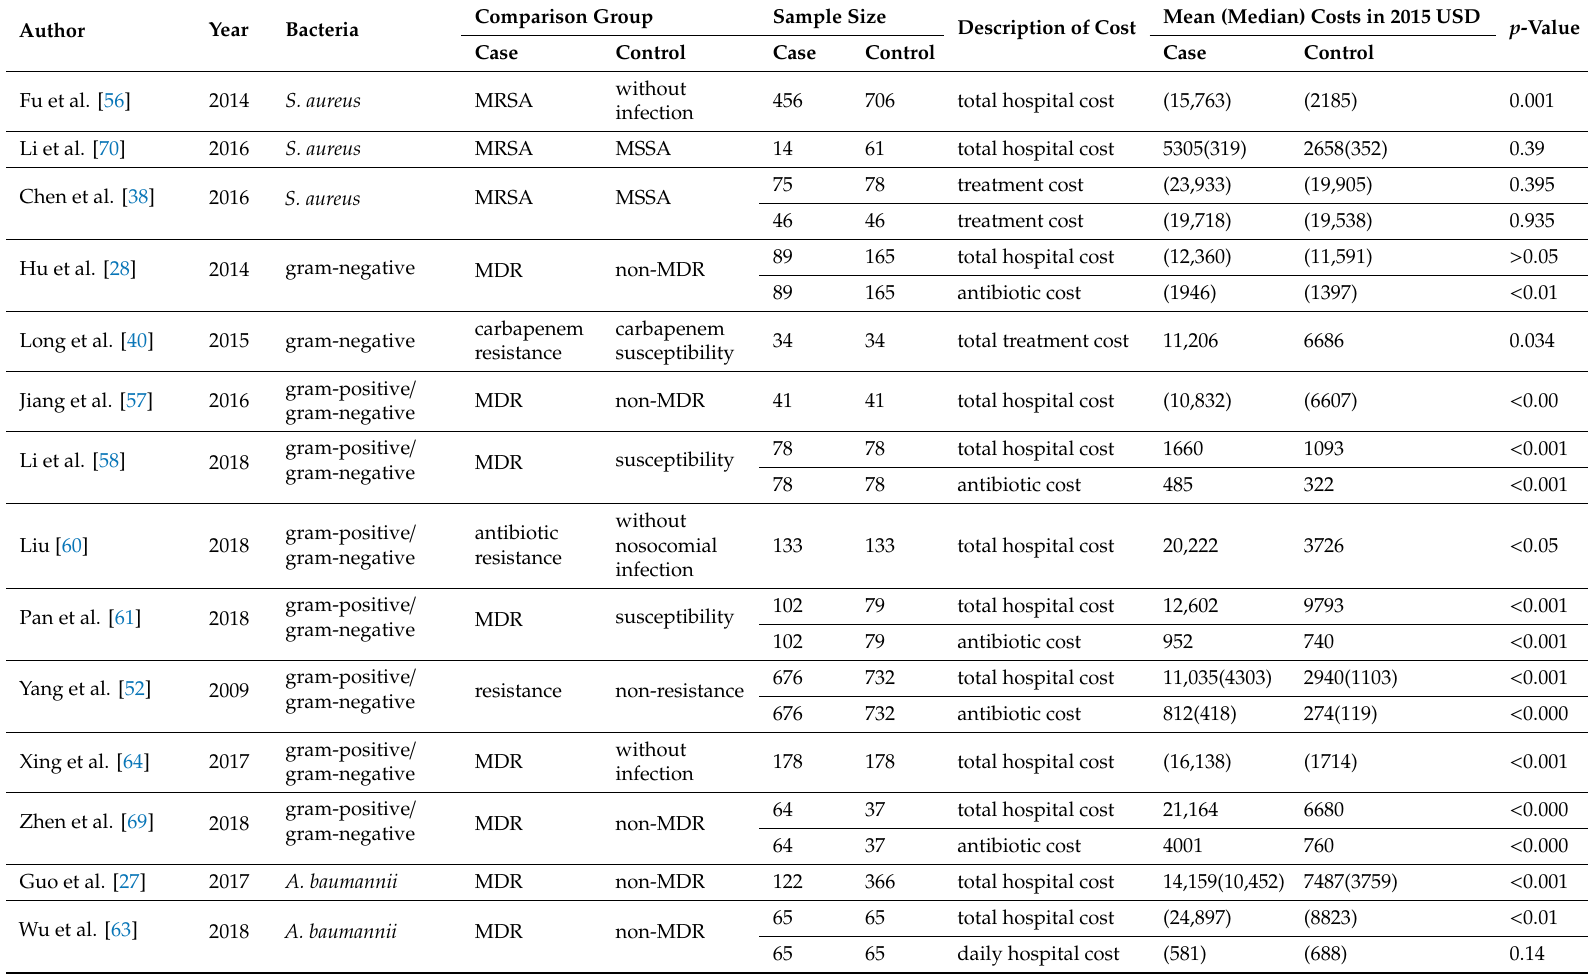
Table 3. Studies describing hospital costs among patients with antibiotic resistance and multi-drug